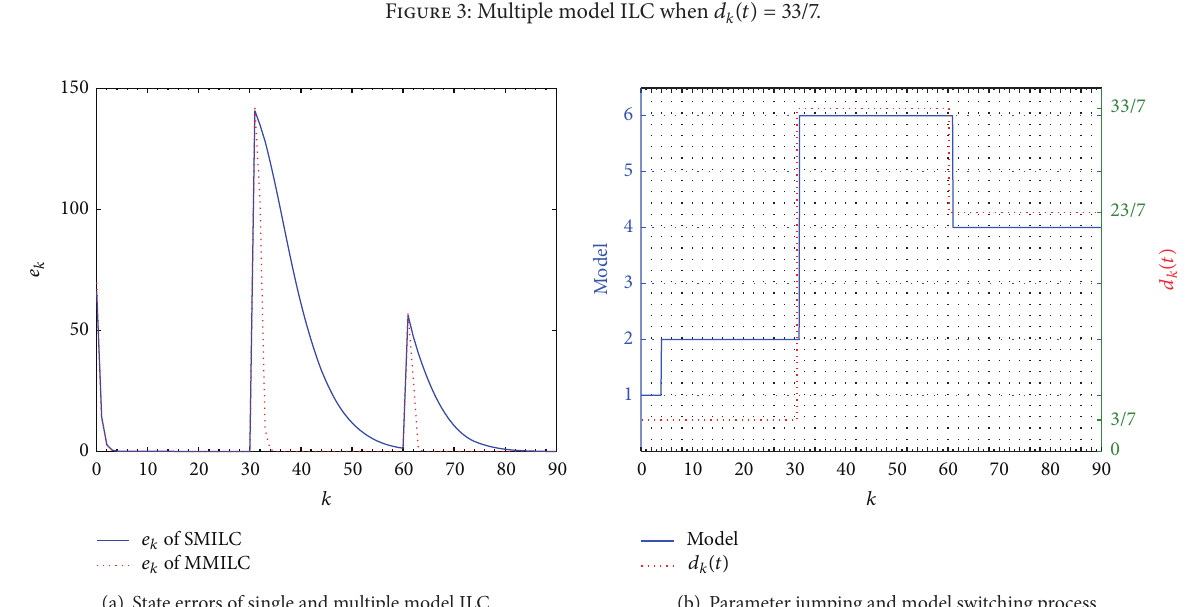
Figure 3: Multiple model ILC when 𝑑 𝑘 (𝑡) = 33/7.